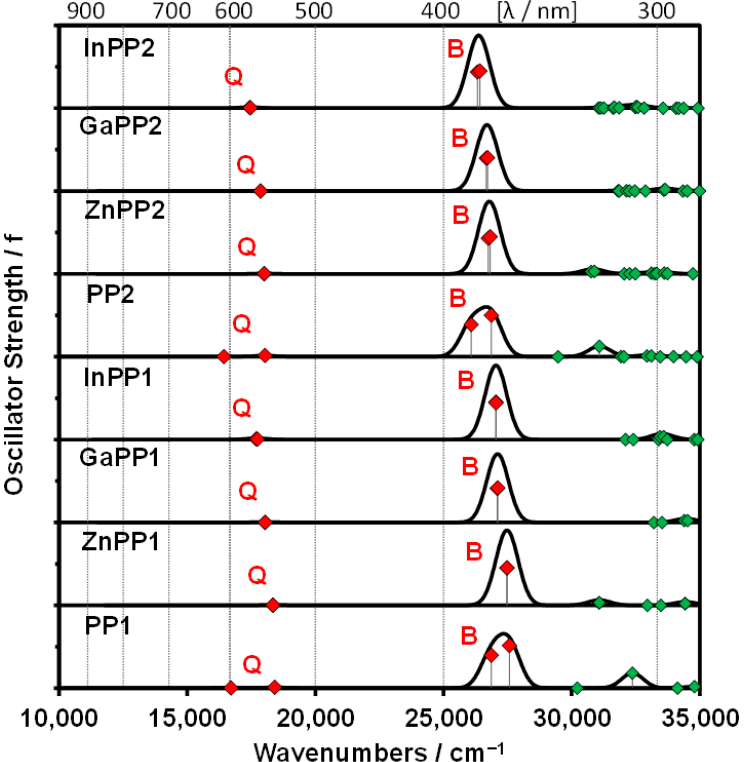
Figure 4. TD-DFT spectra for PP1 , PP2, and the metal complexes using the CAM-B3LYP functional with either SDD or 6-31G(d) basis sets with green diamonds highlighting the oscillator strength values for bands predicted to lie below 35,000 cm − 1 . Large red diamonds are used to highlight the Q and B bands of Gouterman’s 4-orbital model. 33 Simulation of the spectra was carried out using the Chemcraft software package, Version 1.8 (build 536b) with fixed bandwiths of 1000 cm − 1 . Details of the calculations are provided in Table 3. Table 3. Electronic excitation bands of the synthesized porphyrins at the TD-DFT level of theory using the CAM-B3LYP functional with either SDD or 6-31G(d) basis sets.